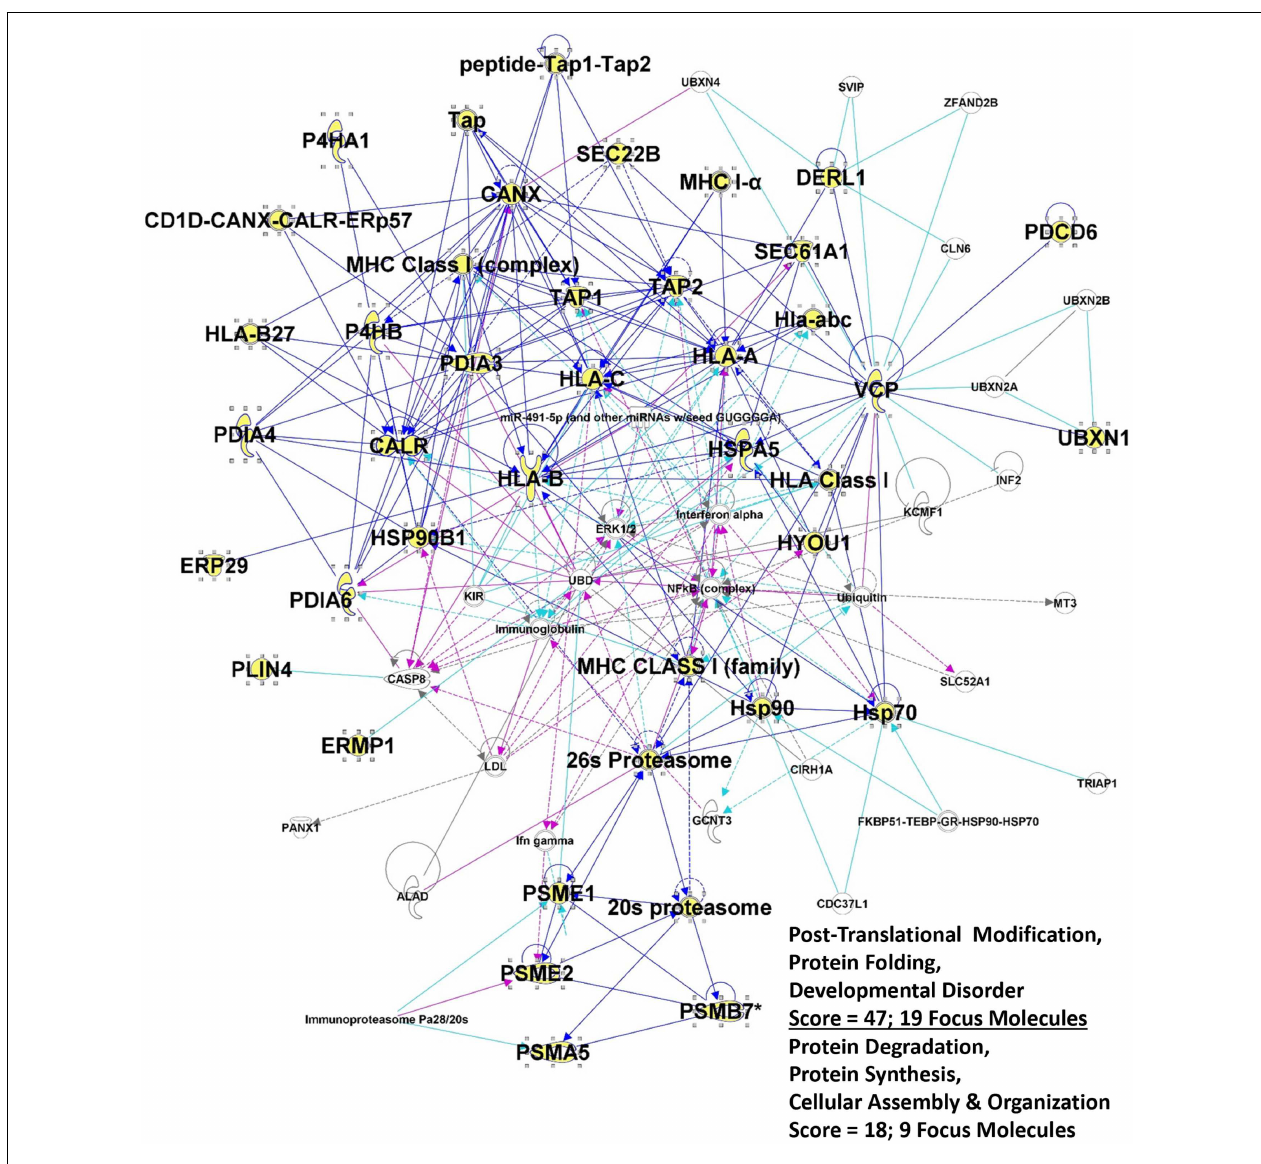
connect proteins from within the entry group; turquoise lines connect proteins that were in the network but not found in our proteomic study. Cranberry colored lines show the intersection of proteins between the two interactomes. “Score” refers to the − log( p -value) from Fisher’s exact score, and “Focus Molecules” are “seeds” for generation of focal points or nodes within the